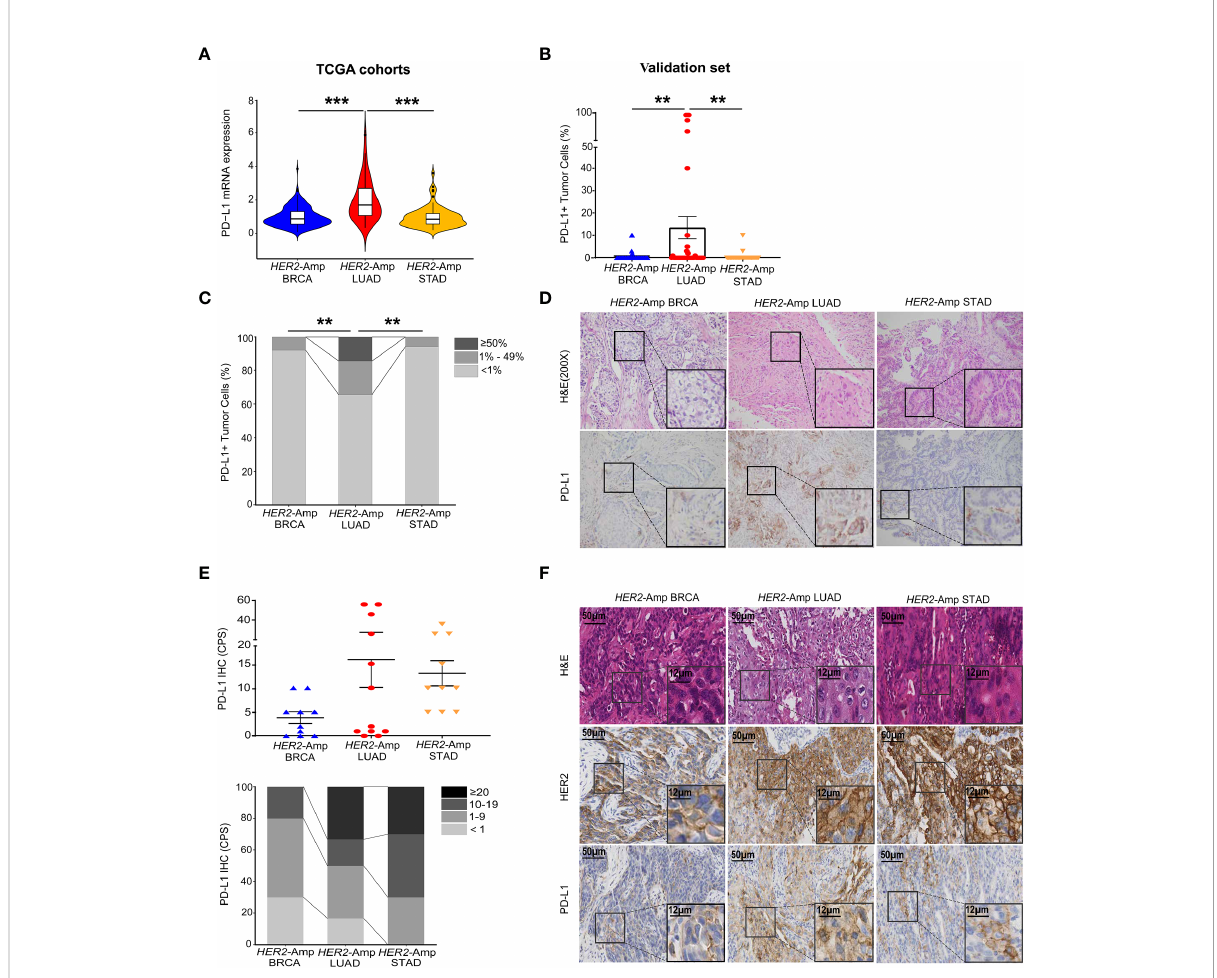
FIGURE 1 Correlation between HER2 ampli fi cation and PD-L1 and/or other immune checkpoint expressions in patients with BRCA, LUAD and STAD. (A) PD-L1 mRNA expression among the HER2- ampli fi ed BRCA cohort (n = 212), HER2 -ampli fi ed LUAD cohort (n = 56) and HER2- ampli fi ed STAD cohort (n = 71) based on analysis of the TCGA database. (B, C) Statistical results of PD-L1 staining in HER2 -ampli fi ed cohorts of 51 BRCA patients, 35 LUAD patients and 35 STAD patients. PD-L1 expression in tumor cells is classi fi ed as ≥ 50%, 1% to 49% and < 1%. (D) Representative images of hematoxylin-eosin (HE) staining and PD-L1 IHC staining in BRCA, LUAD and STAD tissues with HER2 ampli fi cation. (E, F) Statistical analysis (E) and images (F) of HE, HER2 and PD-L1 IHC staining were conducted. PD-L1 expression was assessed at cut-offs of ≥ 20, 10 to 19, 1 to 9 and < 1 based on the combined positive score (CPS). CPS = [(number of PD-L1-positive tumor cells and mononuclear in fl ammatory cells)/ (total number of tumor cells)] × 100. Amp, ampli fi ed; BRCA, breast invasive carcinoma; LUAD, lung adenocarcinoma; STAD, stomach adenocarcinoma. P < 0.05 was regarded as signi fi cantly different. *** P < 0.001, ** P <